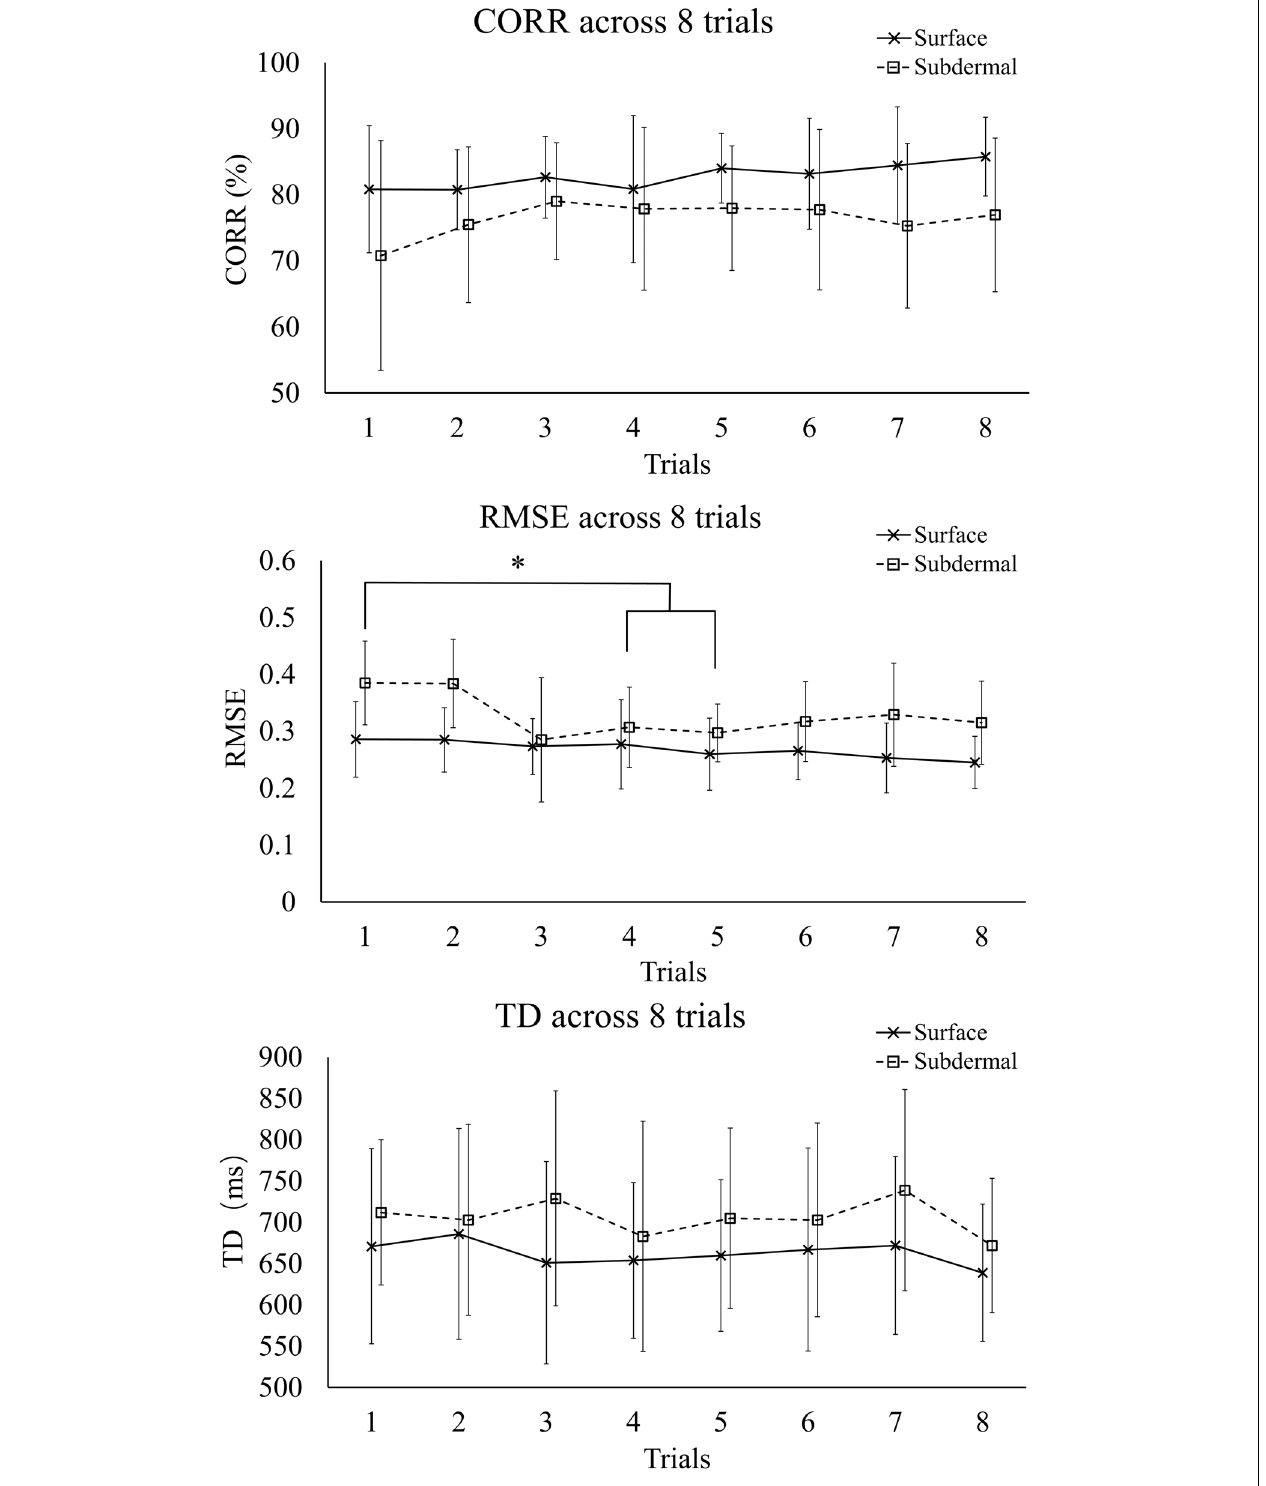
FIGURE 3 | Summary performance (mean ± standard deviation) for CORR, RMSE, and TD across trials. The symbol * indicates a statistically significant difference ( p < 0.05). RMSE, root mean square error; CORR, correlation; TD, time delay.